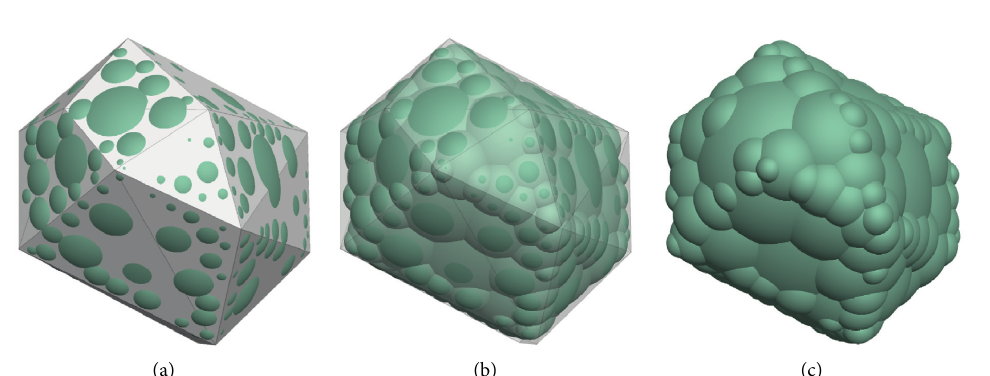
Figure 4: Representation of a polyhedral particle by a clump of spheres by the algorithm in PFC5.0: (a) and (b) the polyhedral particle and the clump; (c) the clump.